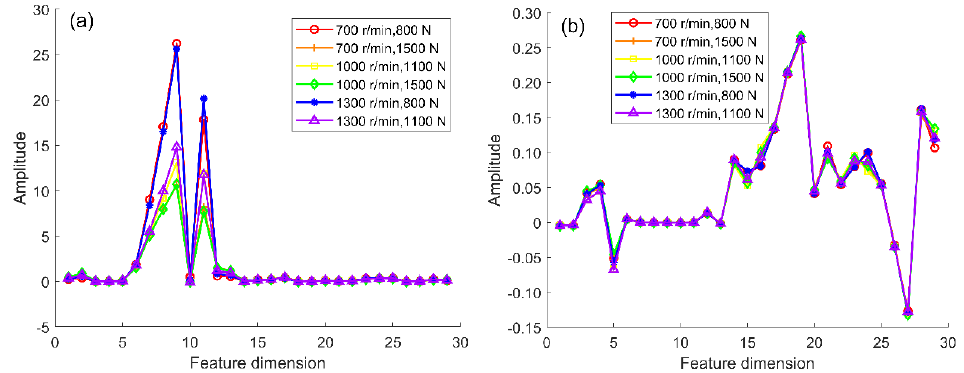
Figure 8. Distribution of features under variable working conditions before and after cDNAP: ( a ) before cDNAP; ( b ) after cDNAP.